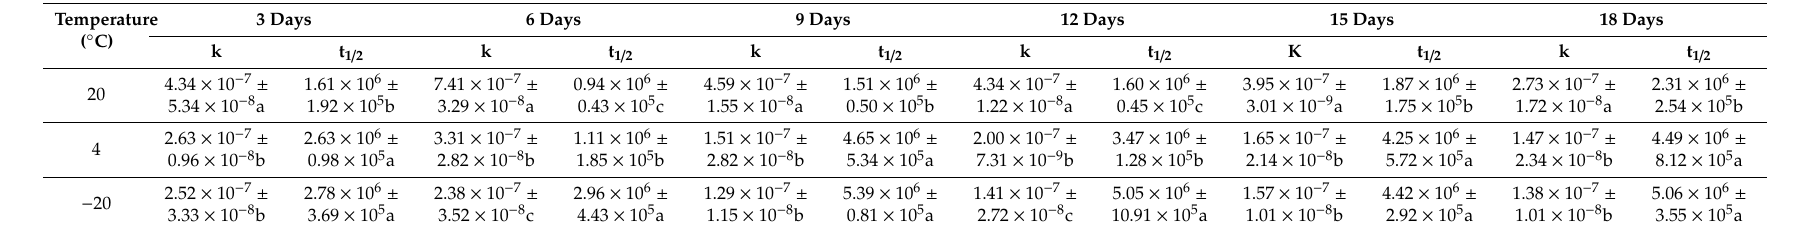
Table 6. E ff ect of storage on the k and t 1 / 2 values of anthocyanin degradation kinetics of Roselle extracted with DES. Temperature ( ◦ C)